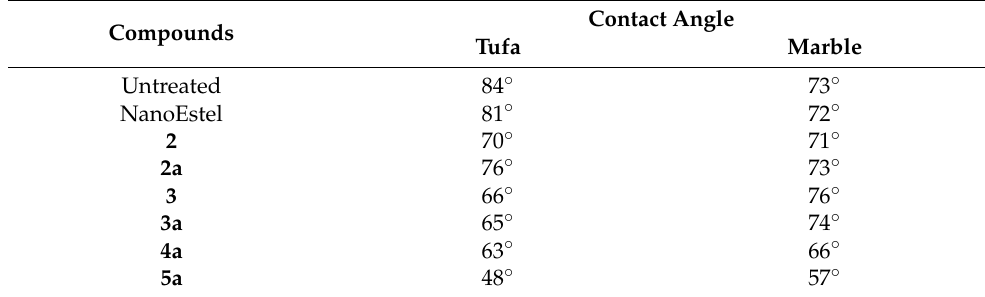
Table 3. Contact angle measurements of the untreated and treated surfaces.